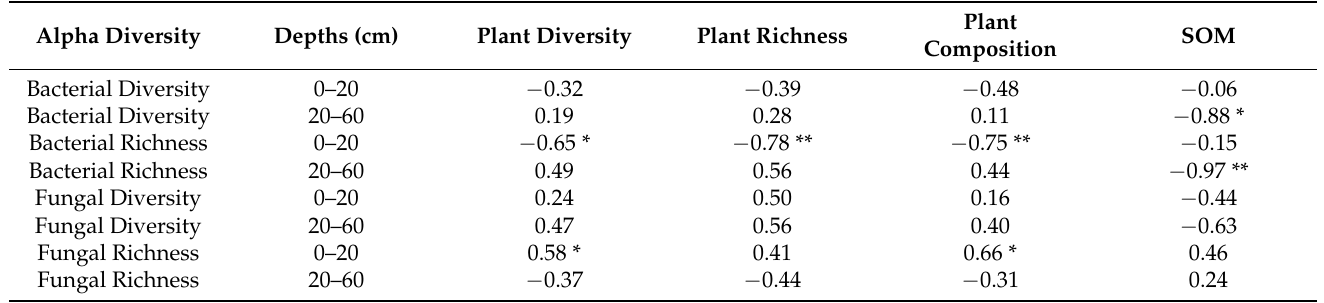
Table 4. Correlations between the alpha diversity of bacteria and fungi, vegetation composition, and soil properties in 0–20 cm and 20–60 cm soil depths of